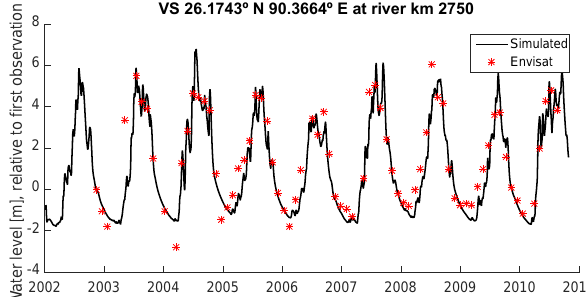
Figure 8. Result of cross-section calibration step 2 for one virtual station. All levels are relative to the water levels at the time of the first Envisat